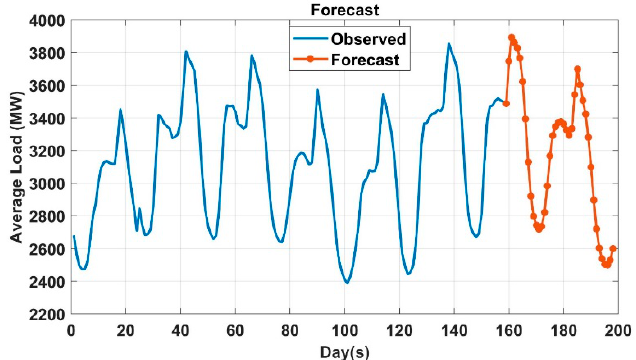
Figure 16. Per-day forecast of future time series.